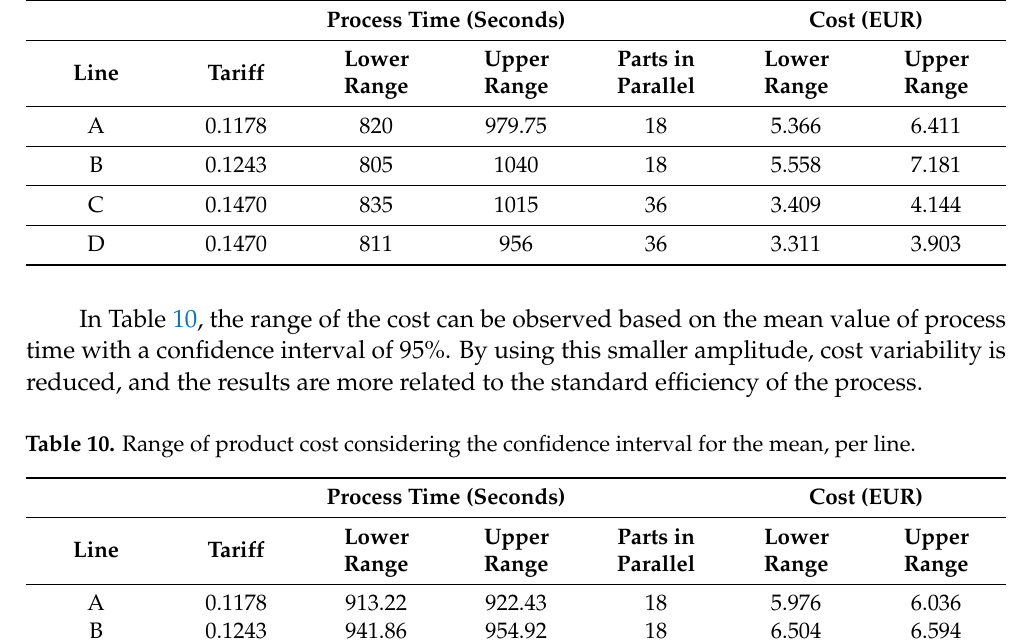
Table 9. Range of product cost considering Q1 and Q3, per line.